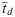
Model predictions agree with neuroblast migration data.(A) Number of mig-1 mRNA molecules per cell as a function of time t, obtained by single-molecule fluorescent in situ hybridization, from [5]. Magenta shows approximate range of times when cell migration terminates. Black lines show mean t¯d (dashed) and standard deviation σd of cell division times (black points). (B) Timing variance vs. linearity of x(t), both for experimental data in A (blue circle) and our model (curves, Eqs 16 and 17). Data analyzed using ranges of threshold 10 ≤ x* ≤ 25 and bin size 3 ≤ Δx ≤ 12; error bars show standard deviations of these results. We see that for sufficiently large cost 〈a〉/x* or 〈r〉/x*, model predictions agree with experimental data point.